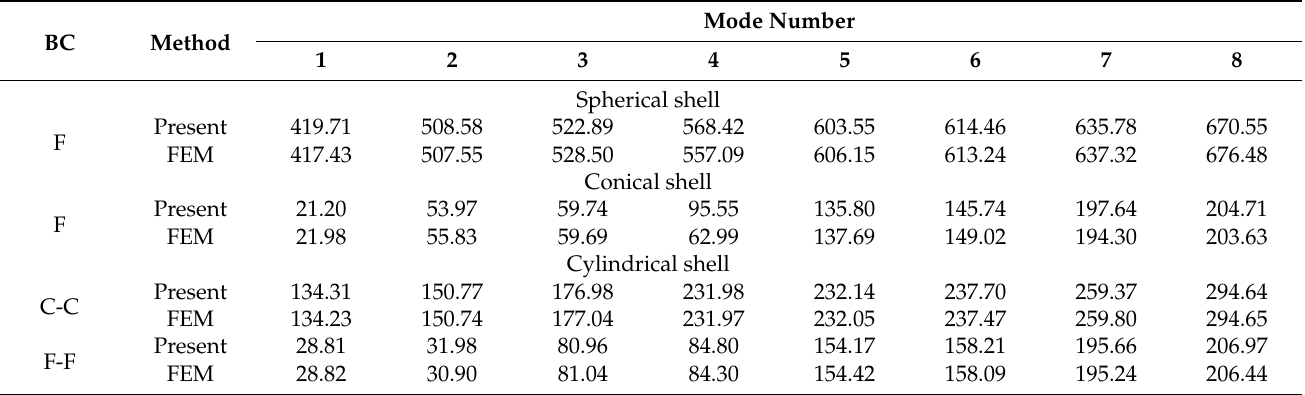
Table 1. Comparison of calculation frequency of spherical, conical, and cylindrical shell with lami- nated